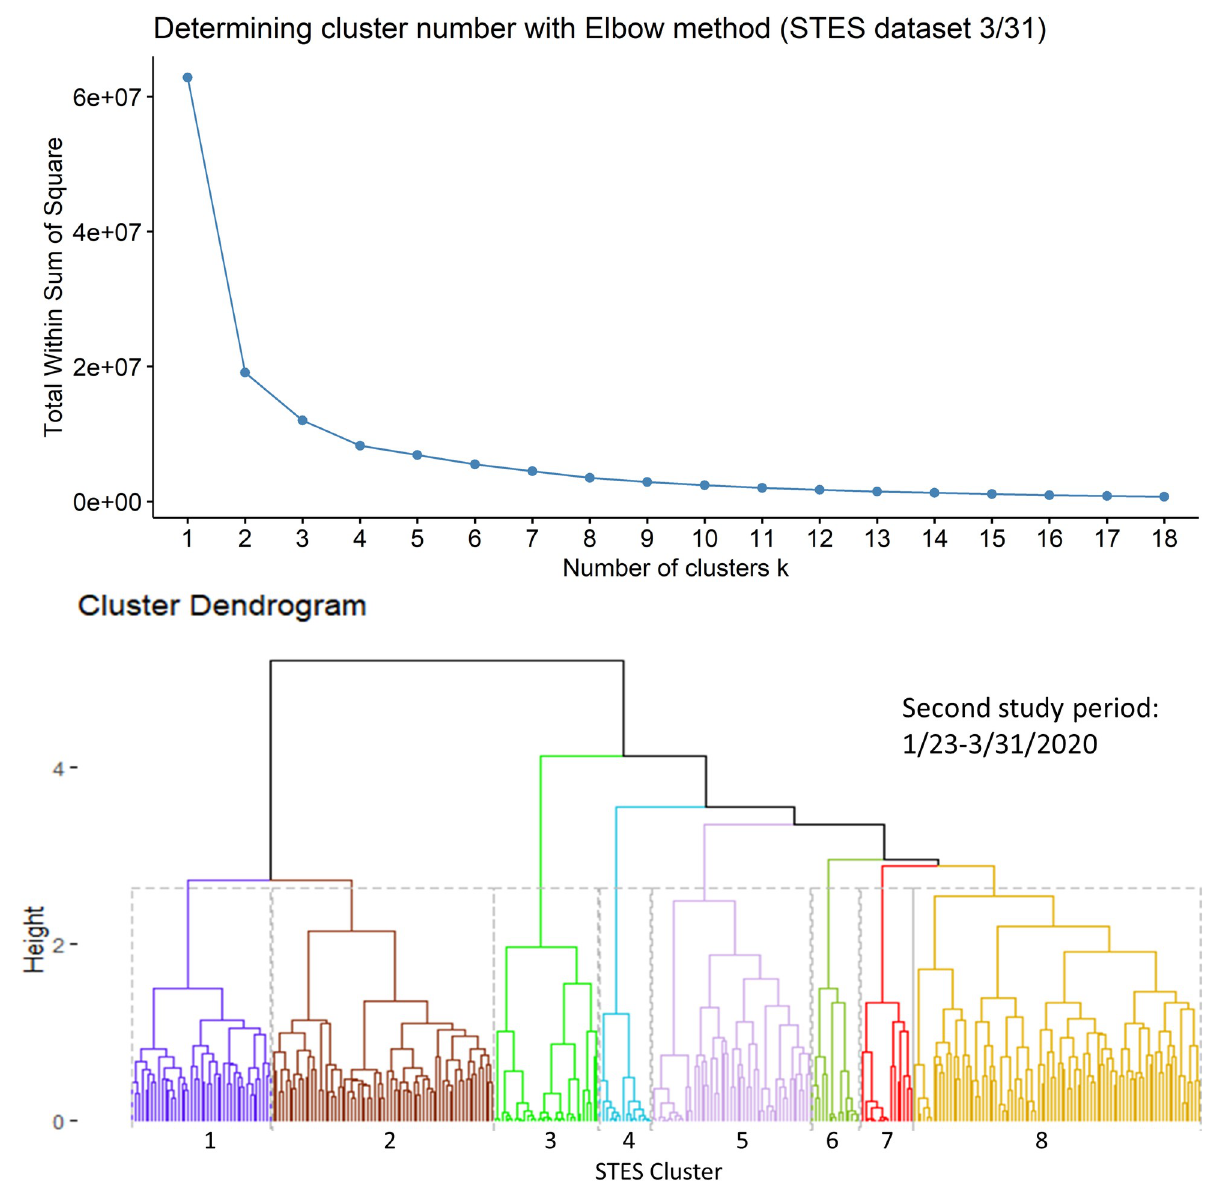
Fig 5. Elbow method evaluation and hierarchical clustering results for the 2 nd period. Notice that the numberings and colors of STES clusters match with those of corresponding clusters on the map and the temporal trend graph in Fig